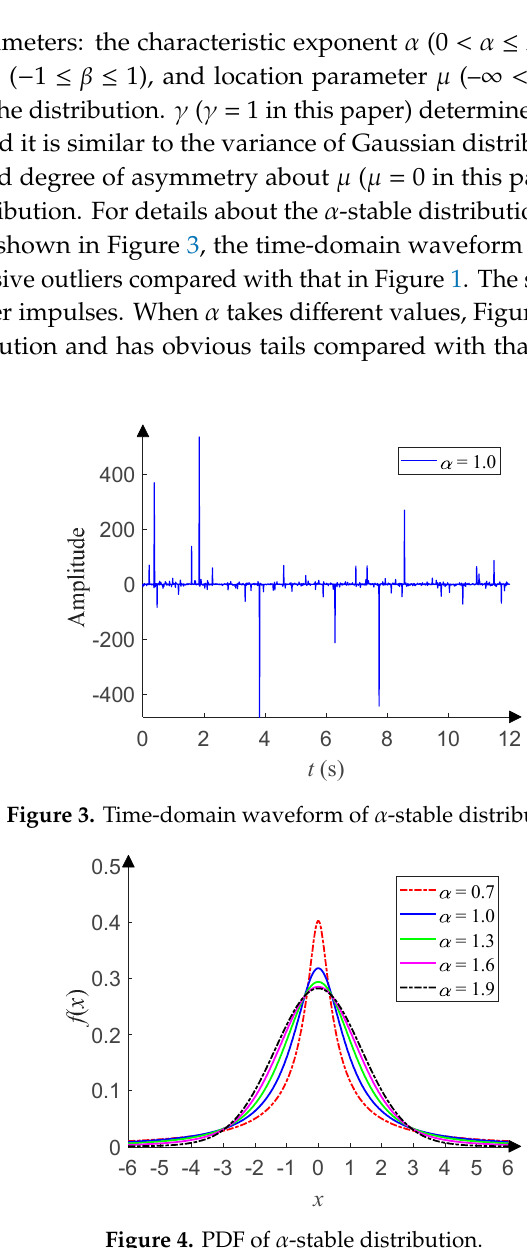
Figure 4. PDF of α -stable distribution.